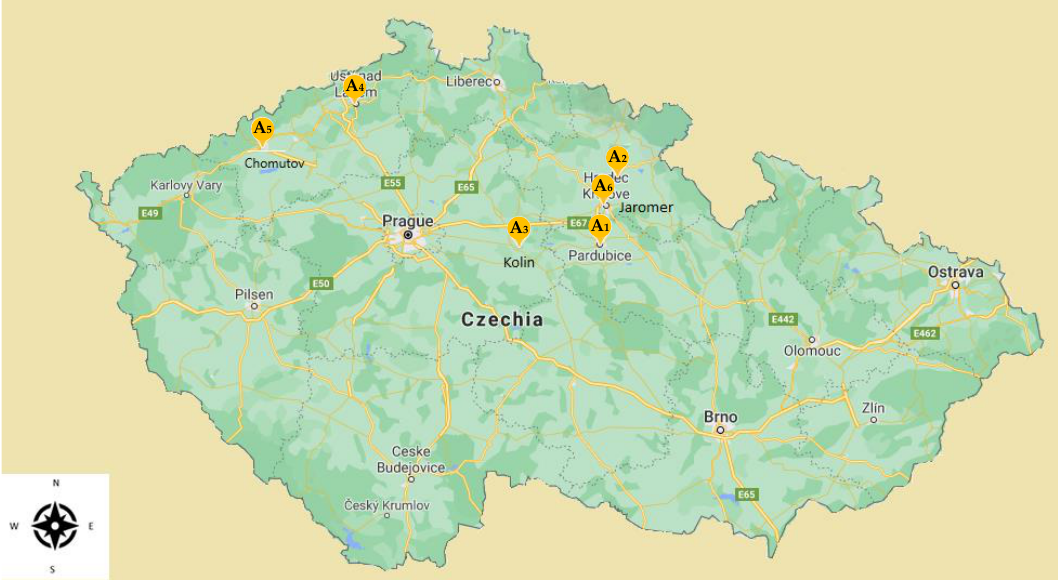
Figure 2. Locations of six assessed railway infrastructures in the Czech Republic.